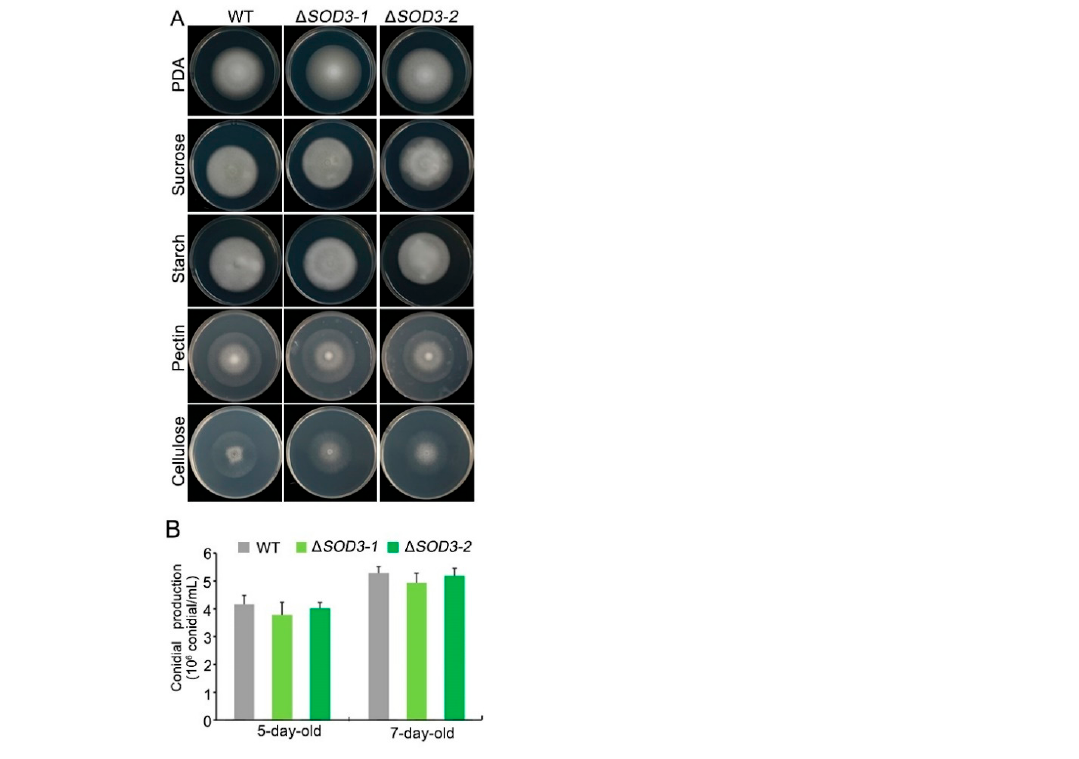
Figure 5. VdSOD3 is not required for fungal growth, carbon source utilization and conidia production in vitro. ( A ) The wild-type strain and ∆ SOD3-1/2 were grown on potato dextrose agar (PDA) plates and CM plates containing different carbon sources (sucrose, starch, pectin and cellulose) for 9 days. ( B ) Quantification of conidia production of the wild-type strain and ∆ SOD3-1/2 from 5- and 7-day-old fungal colonies, respectively.